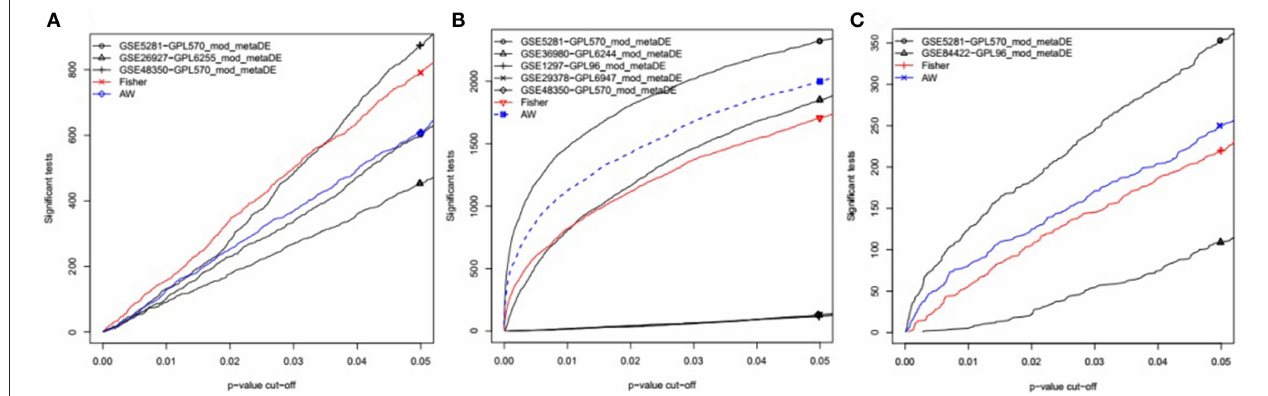
FIGURE 1 | P -value vs. number of detected DEGs for individual analysis as well as meta-analysis. In each individual dataset, moderated-t statistics was used to generate p-values while adaptive weight and Fisher’s methods were utilized to combine these p -values for meta-analysis. This figure is generated using the “MetaDE” package in R. (A) The datasets from Entorhinal Cortex; (B) the datasets from Hippocampus; (C) the datasets from Medial temporal gyrus.